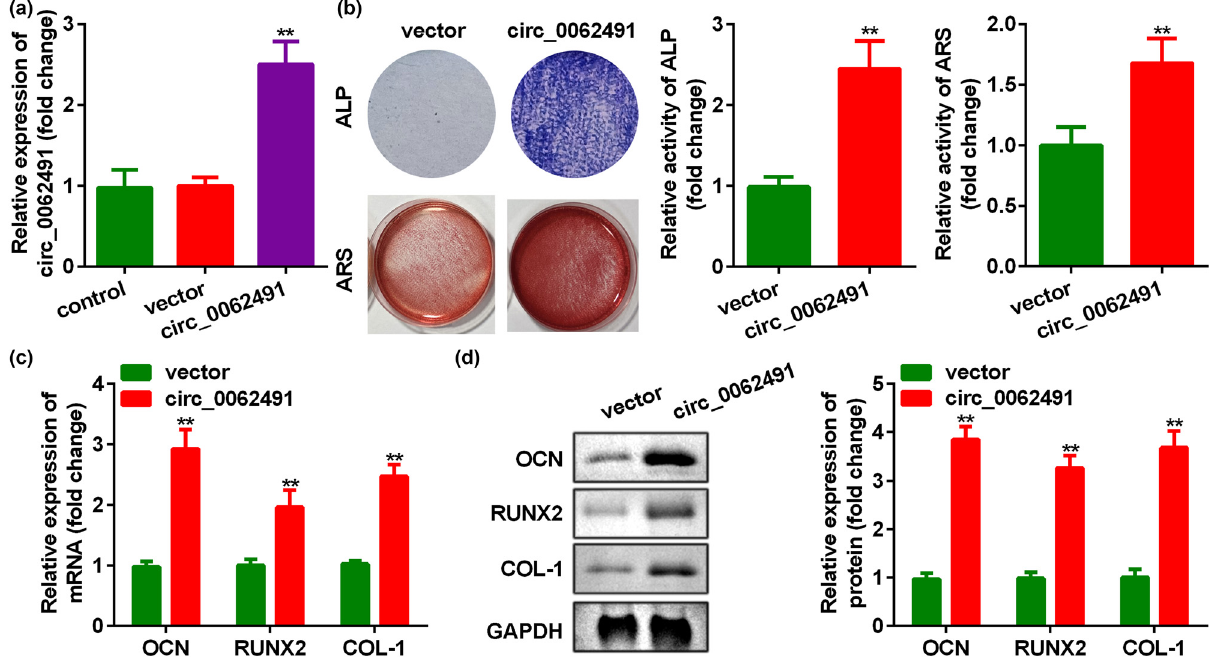
Figure 2: Overexpressed circ_0062491 promoted osteogenic di ff erentiation of PDLSCs. ( a ) circ_0062491 expression levels were detected by qRT - PCR in PDLSCs after transfection. ( b ) Images and quanti fi cation of ALP staining and ARS of PDLSCs transfected with circ_0062491. ( c ) qRT - PCR analysis for the expression of OCN, RUNX2, and COL - 1. ( d ) Western blotting analysis for the expression of OCN, RUNX2, and COL - 1. ** p < 0.01, vs the vector